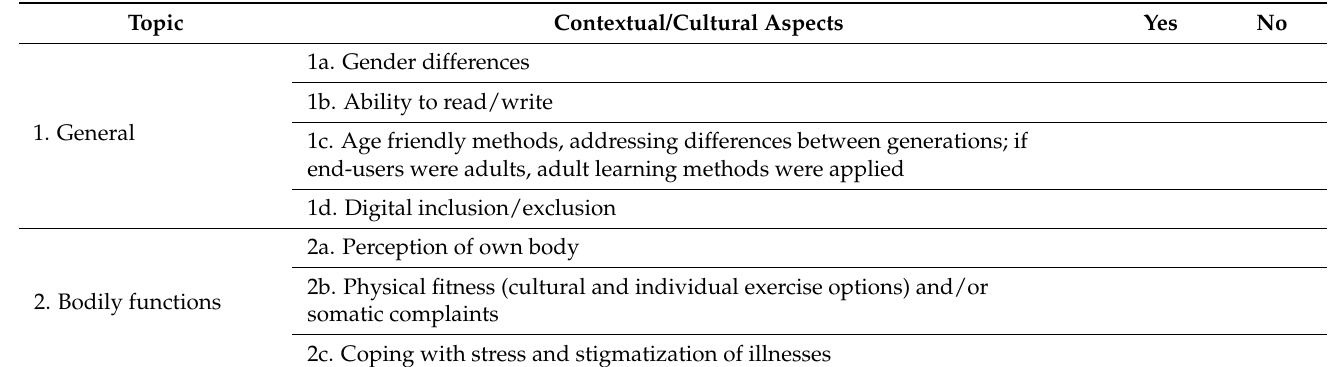
Table 2. Checklist for cultural and contextual adaptation of community-based health interventions